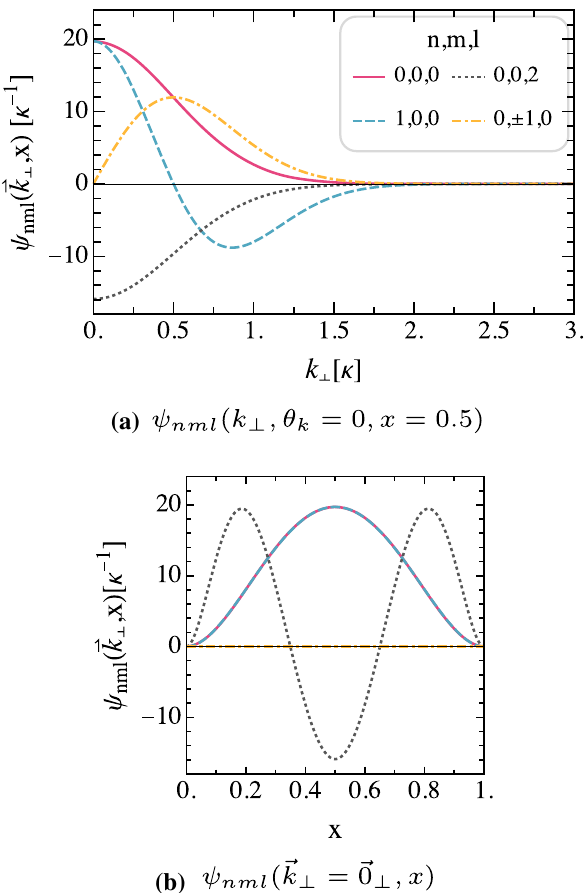
Fig. 1 The basis function ψ nml ( (cid:3) k ⊥ , x ) [defined in Eq. (10)]: a as a function of k ⊥ (in the unit of κ ) at θ k = 0 and x = 0 . 5, and b as a function of x at (cid:3) k ⊥ = (cid:3) 0 ⊥ . Note that in b , the curves of ψ 000 and ψ 100 are the same, and ψ 0 , ± 1 , 0 is zero. In the plots, we take α = β = 4, and the basis function is in the unit of κ −